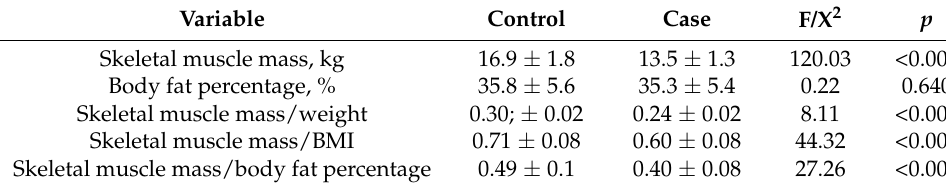
Table 3. Comparison of dietary intake between the control and case